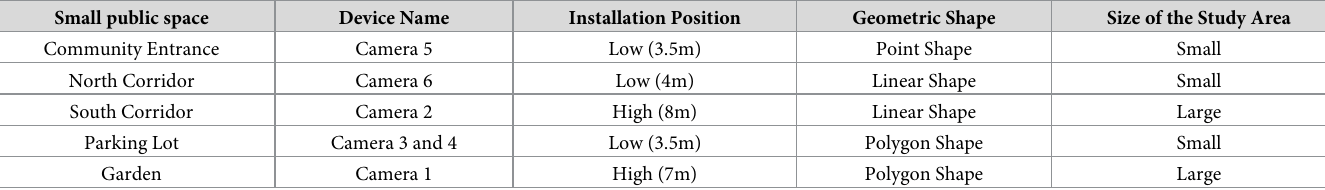
Table 4. Installation of photographic